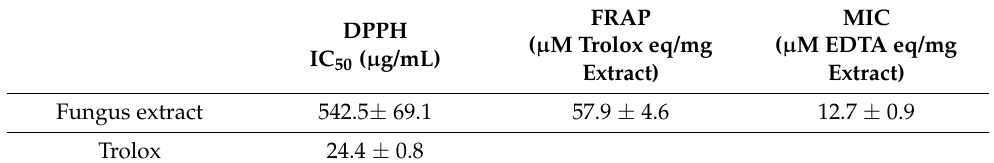
Table 3. Antioxidant activities of P. chysogenum MZ945518 ethyl acetate extract.